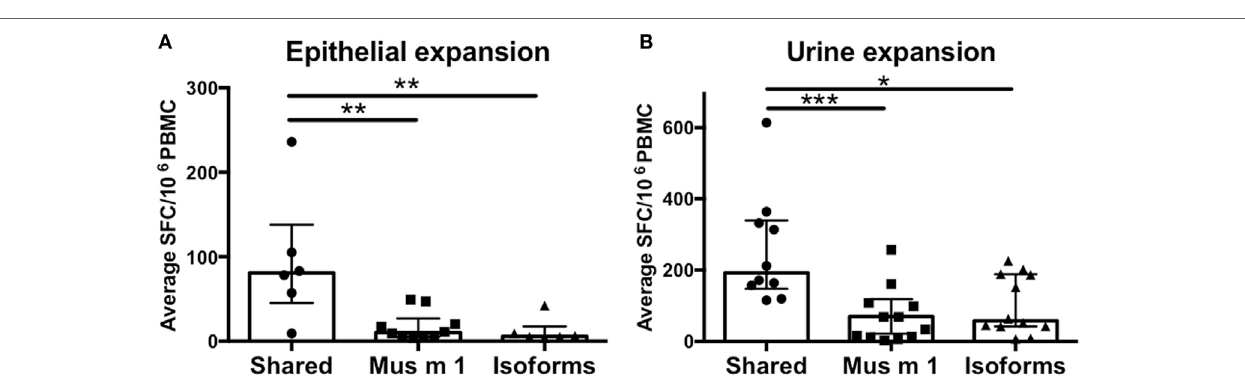
FigUre 2 | T cell reactivity against conserved vs. non-conserved major urinary protein (MUP) peptides. Cytokine production (IL-5 + IFN γ ) was measured as spot forming cells (SFC) by ELISPOT in response to Mus m 1-unique, other MUP isoforms-unique, or conserved (shared) peptides after expansion with (a) epithelial extract or (b) mouse urine. Statistical analysis was performed by Mann–Whitney test, one-tailed. * p < 0.05, ** p < 0.01, and *** p <